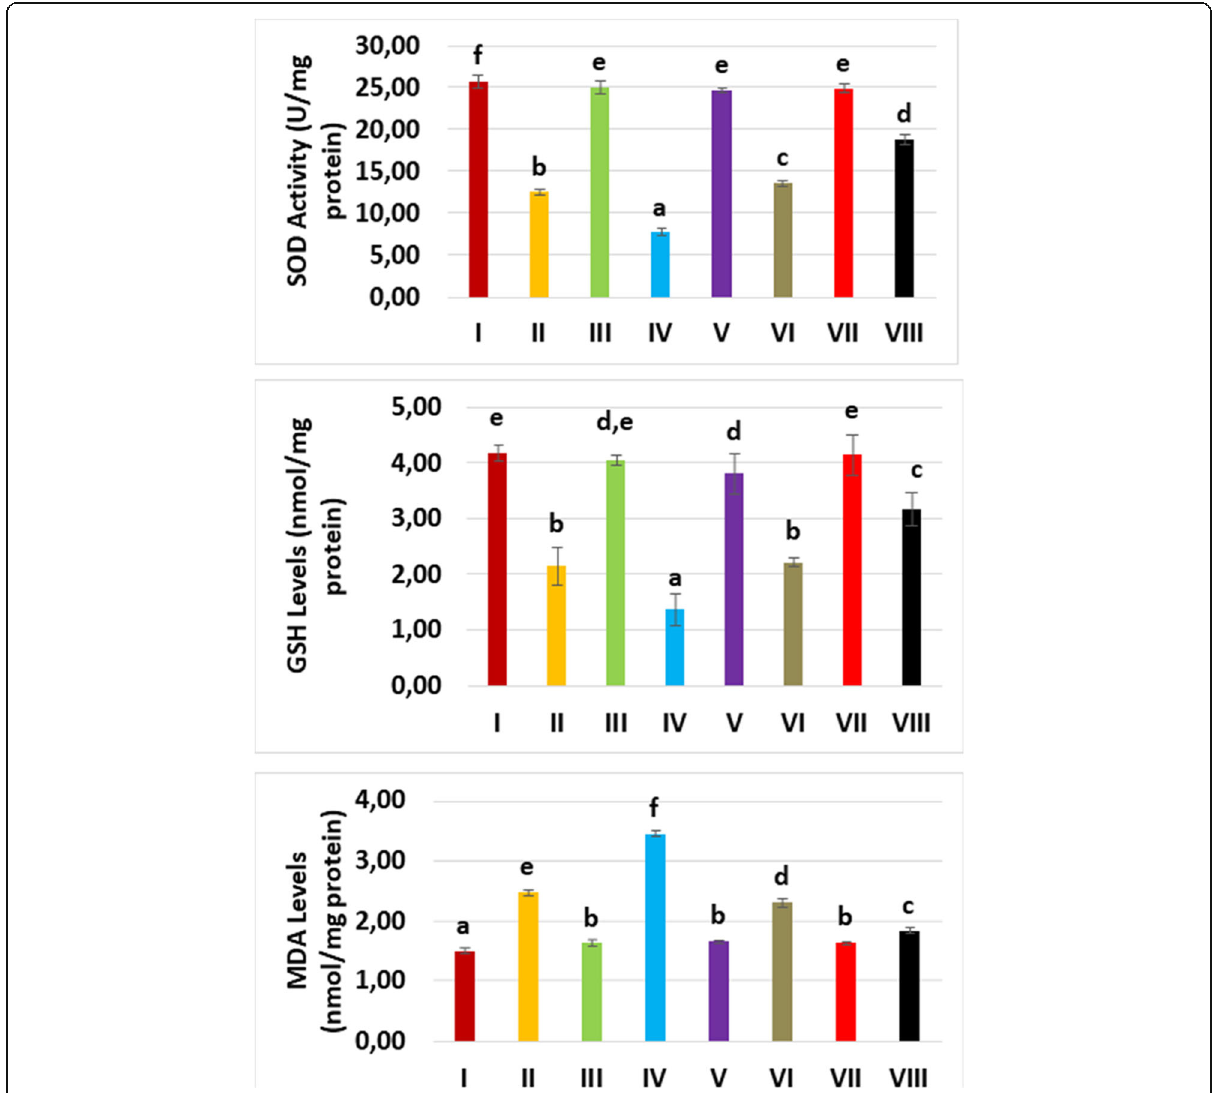
Fig. 3 The superoxide dismutase (SOD) activity, glutathione (GSH), and malondialdehyde (MDA) levels of all experimental groups. Although the glycerol and contrast media administration compromised SOD and GSH, levosimendan promotes SOD and GSH. An opposite effect of glycerol, contrast media, and levosimendan has been experienced for